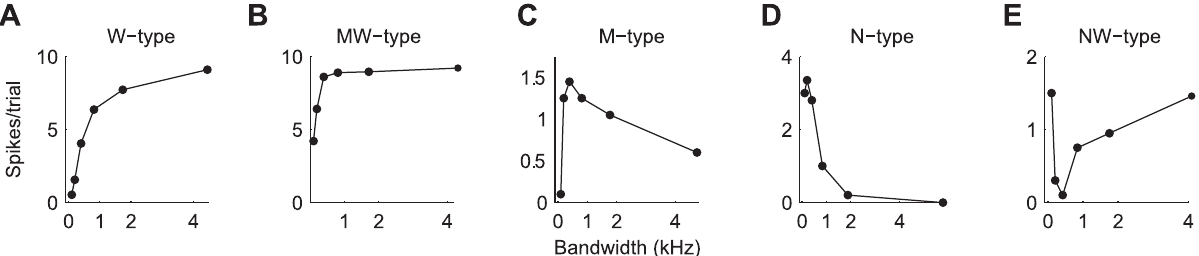
Figure 4. Representative examples of the different types of responses to M m as a function of bandwidth. A: monotonically increasing (W-type). B: monotonically increasing response that saturates (MW-type). C: M-type neuron showing an initial increase followed by a decrease. D: Decreasing response (N-type). E: initial decrease in response followed by an increase (NW-type).